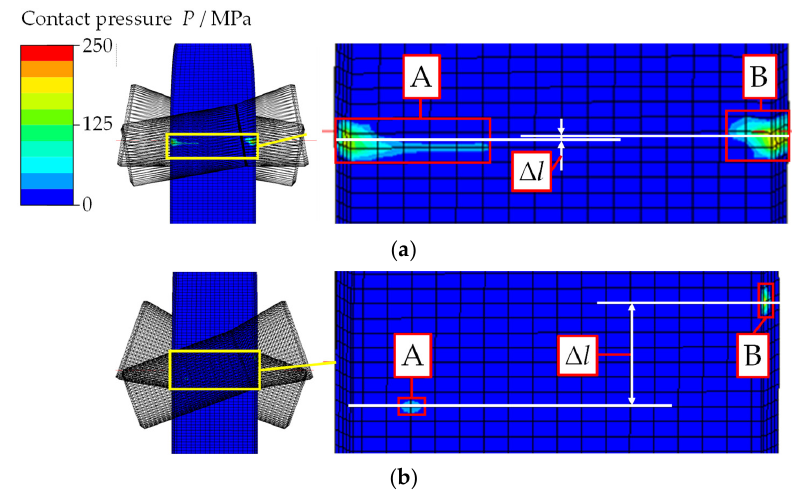
Figure 15. Contact pressure: ( a ) skew angle φ = 10° and ( b ) skew angle φ = 20°.